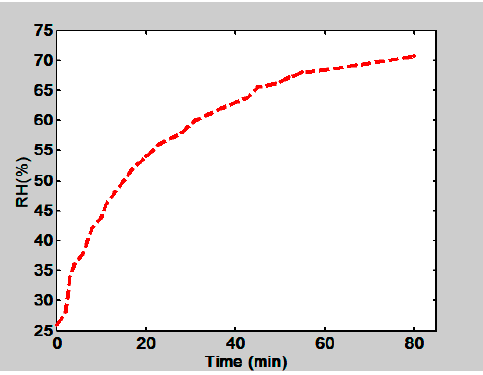
Figure 18. Behavior of RH in the climatic chamber as a function of time. RH was measured inside the climatic chamber when the petri dish lid that contained water was displaced.